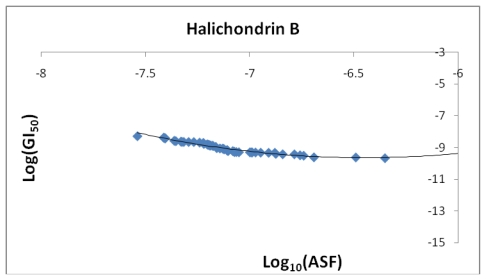
After being sorted by magnitude, the log(GI)50 for halichondrin is plotted against the log(ASF). The best fit equation is y = 1.3375x2 + 17.258x + 46.007 (R2 = 0.9509).